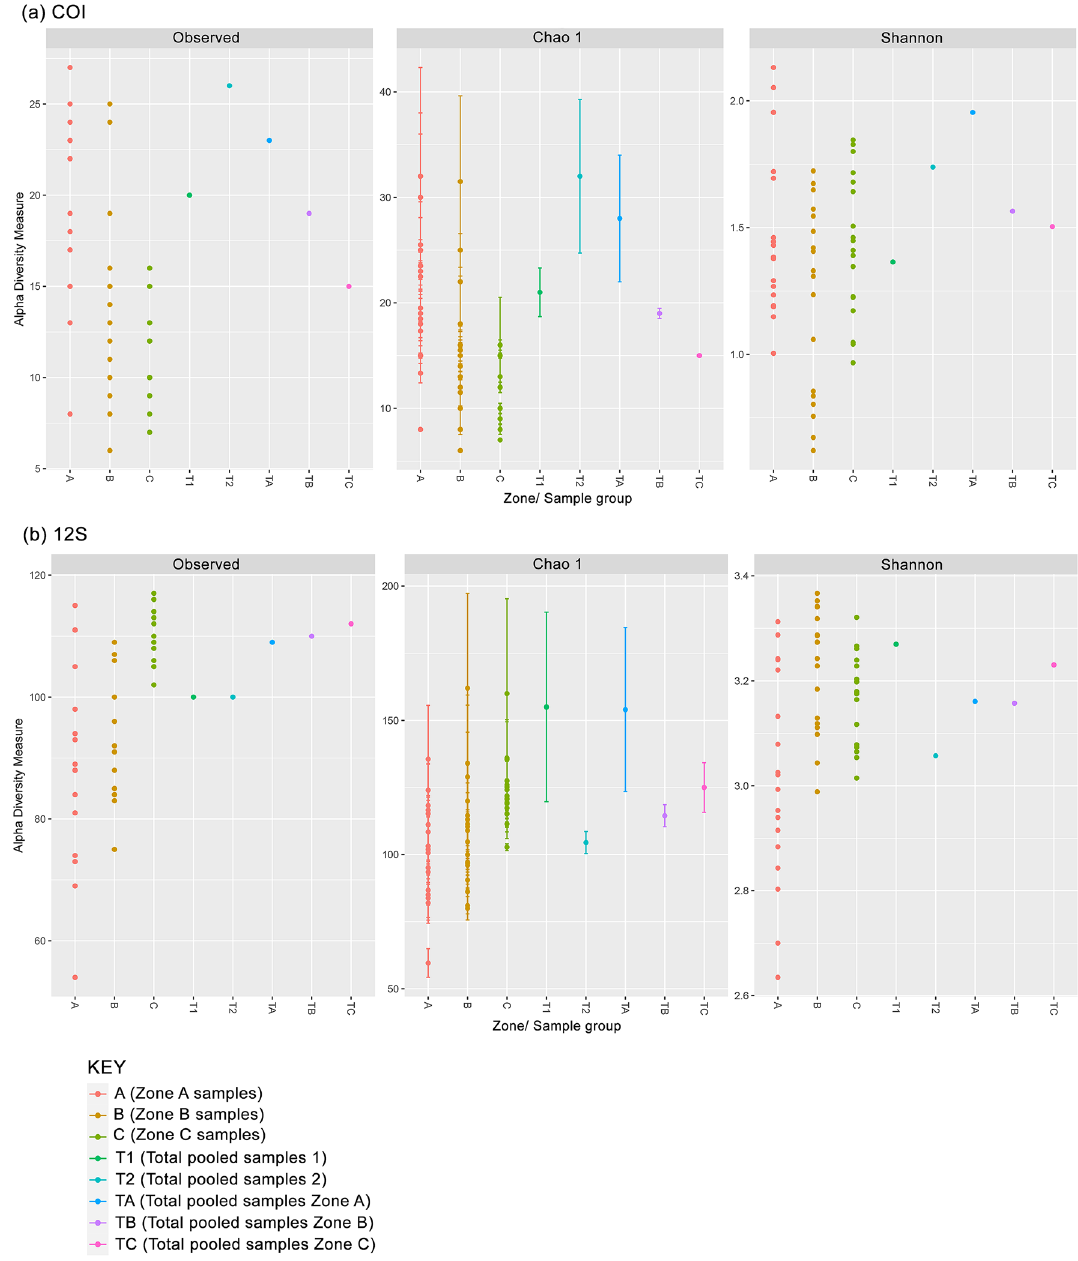
Figure 5. Alpha (α) diversity plots based on Observed, Chao1, and Shannon estimators grouped by zones and sample pools: ( a ) COI assay and ( b ) 12S